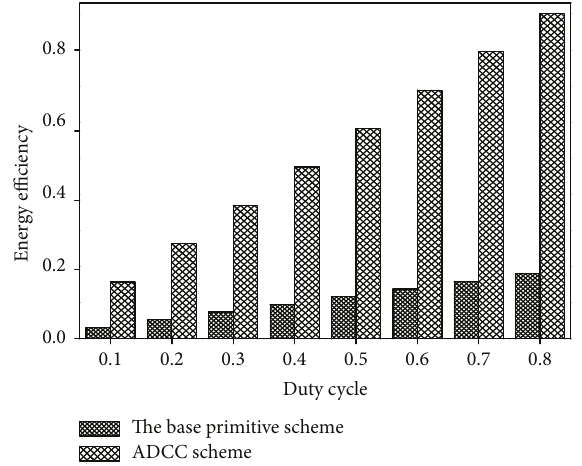
Figure 19: The network utilization rate.